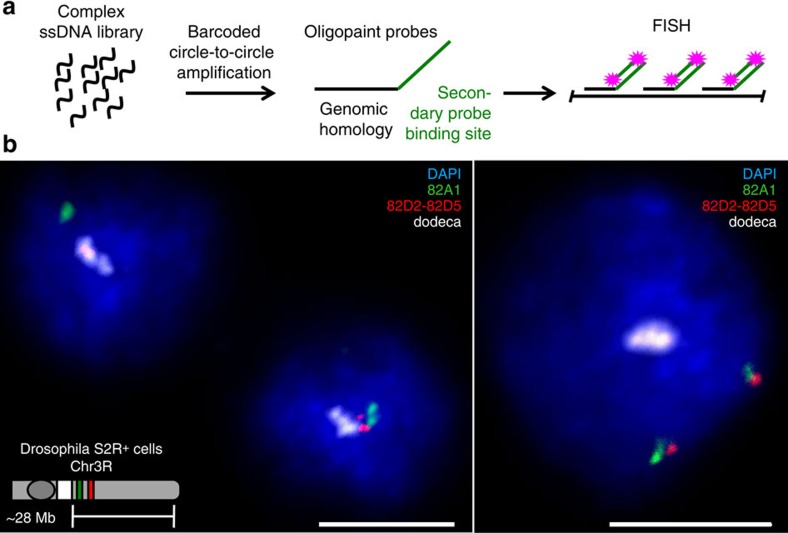
Highly efficient Oligopaint FISH with probe sets made by barcoded c2ca.(a) A cartoon that illustrates the structure of c2ca-amplified Oligopaint probes and the secondary oligonucleotide strategy152728 used to recruit fluorescent label (b). Two confocal images of three-colour FISH performed in Drosophila S2R+ cells with a probe set of 679 oligonucleotides targeting 56 kb at 82A1 (green), a probe set of 719 oligonucleotides targeting 50 kb at 82D2-82D5 (red) and a single oligonucleotide targeting the highly repetitive dodeca percentromeric satellite sequence (white). The Oligopaint probes were visualized by the addition of fluorophore-labelled secondary oligonucleotides complementary to binding sequences encoded in the probe molecules (left panel: 82A1—ATTO565, 82D2-82D5—ATTO488; right panel: 82A1–6-FAM, 82D2-82D5—TYE563), while the dodeca probe carried a Cy5 direct label. Note that Drosophila pairs its homologous chromosomes in somatic cells; therefore, most cells are expected to have only one focus despite that fact that S2R+ cells are tetraploid for chromosome 3. Images are maximum Z projections. Scale bars, 5 μm.